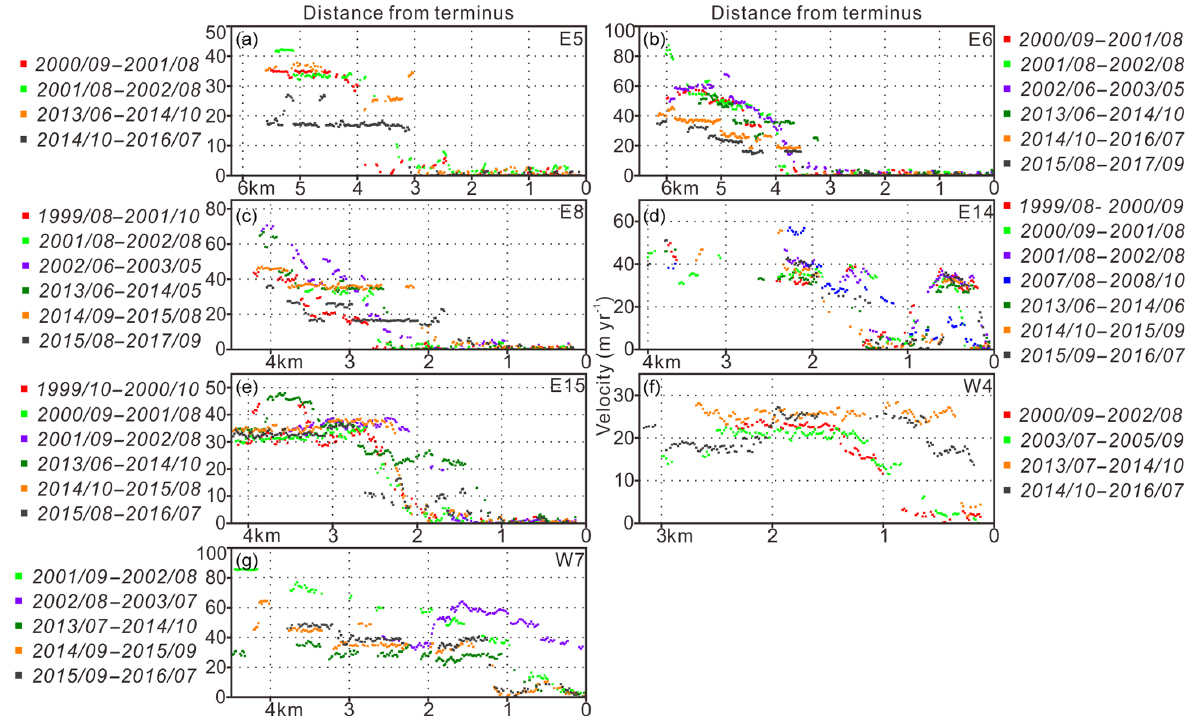
Figure 6. Centre line annual-velocity profiles for stable glaciers: (a) E5, (b) E6, (c) E8, (d) E14, (e) E15, (f) W4, and (g) W7. Note that profiles of W7 start from the clean ice boundary rather than the glacier